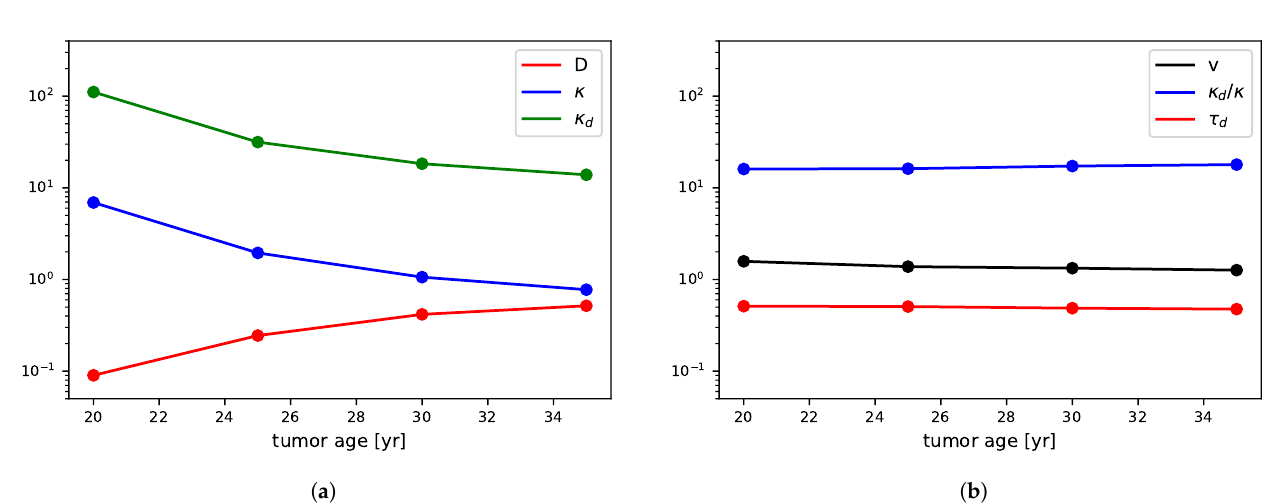
Figure 6. ( a ) Value of diffusion, proliferation, and death rate coefficients of the four models corresponding to the bottom points from Figure 3a ( ∆ χ 2 < 1). ( b ) The same for the transformed set of variables described in the text.